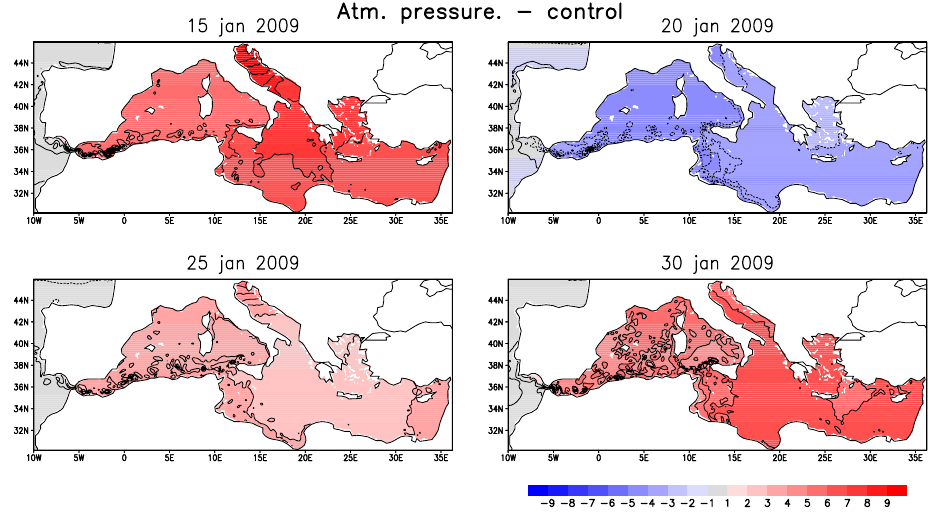
Fig. 2. Snapshots of differences of sea level (cm) in January 2009 between simulations forced with and without the atmospheric pressure gradient. Simulations started on 1 January 2009, and snapshots are on days 15, 20, 25 and 30 after the start of the simulation. Isolines are drawn with the interval of